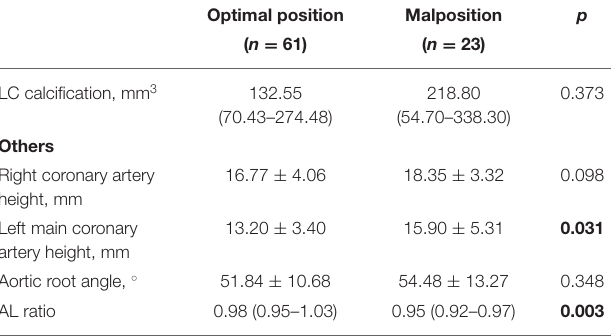
TABLE 3 | Procedural characteristics.